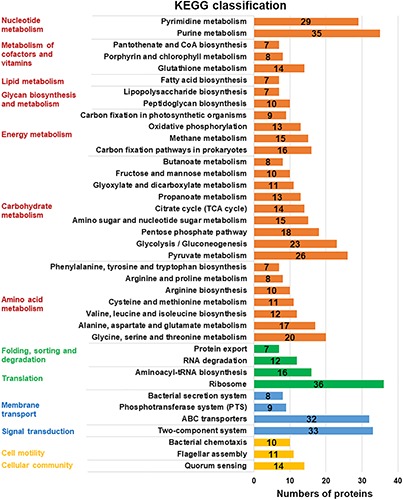
KEGG pathway clusters of assembled uniproteins. Metabolic pathways in different functional groups involved in cold response were classified with KEGG database in four related categories (protein numbers of each group higher than 10): “metabolism” in red, “genetic information processing” in green, “environmental information processing” in blue, and the “cellular processes” in yellow. The subcategory titles were also represented.